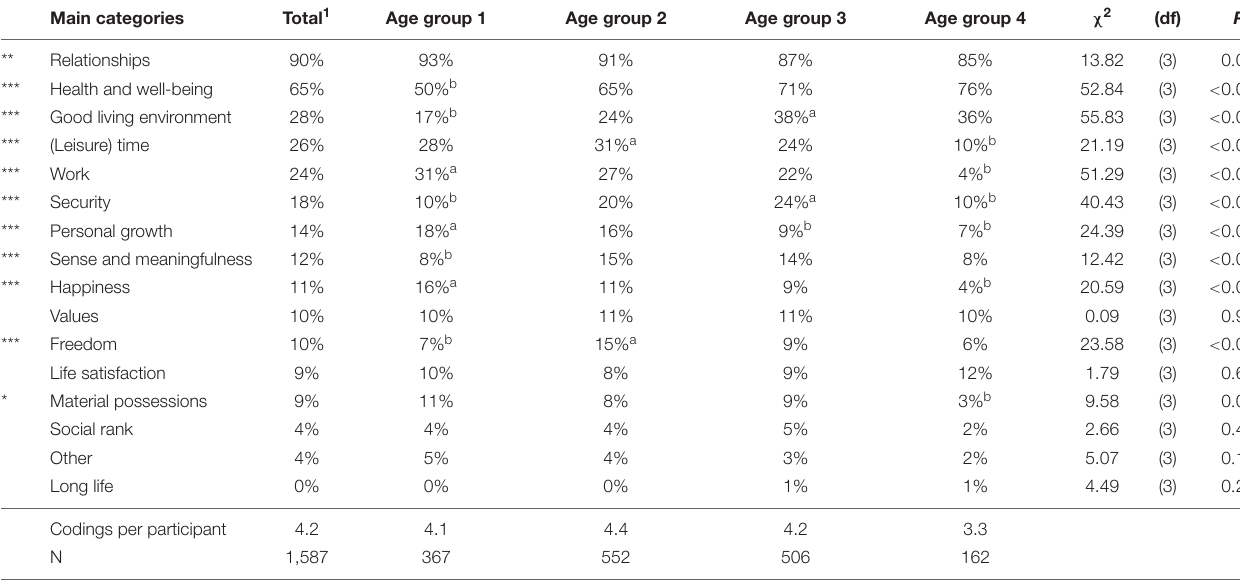
1 Table is sorted in descending order in column “Total”. a Standardized residuals ≥